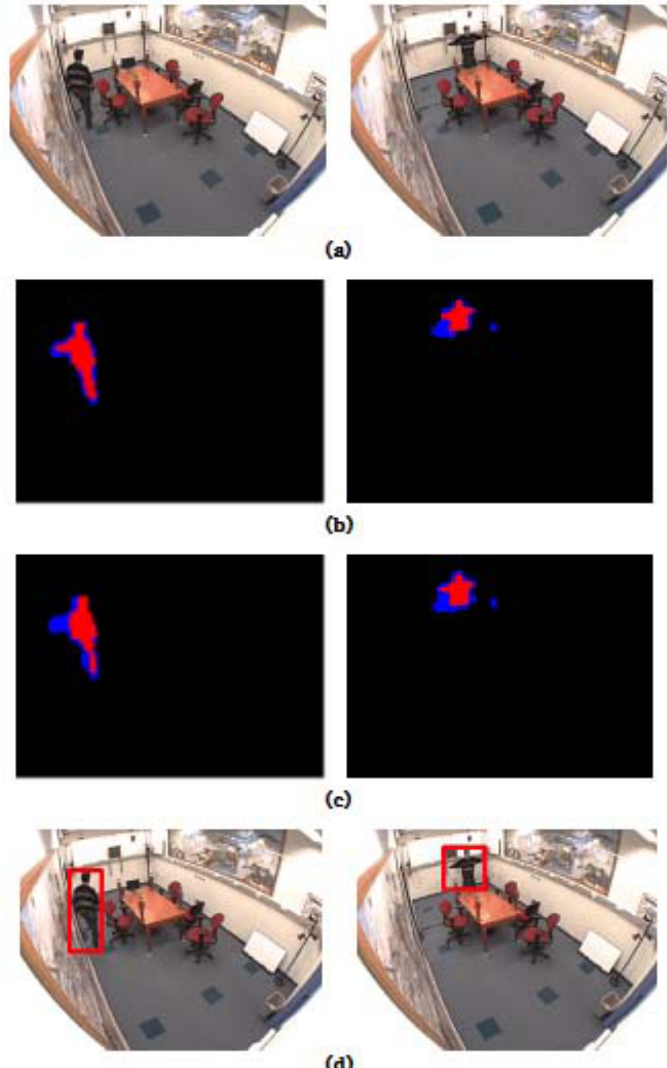
Figure 1. Segmentation results for image sequence “intelligent room”: ( a ) Original images; ( b ) Segmentation results with FSD using our shadow removal algorithm; ( c ) Segmentation results with FSD and SSD using our shadow removal algorithm; ( d ) Results of object